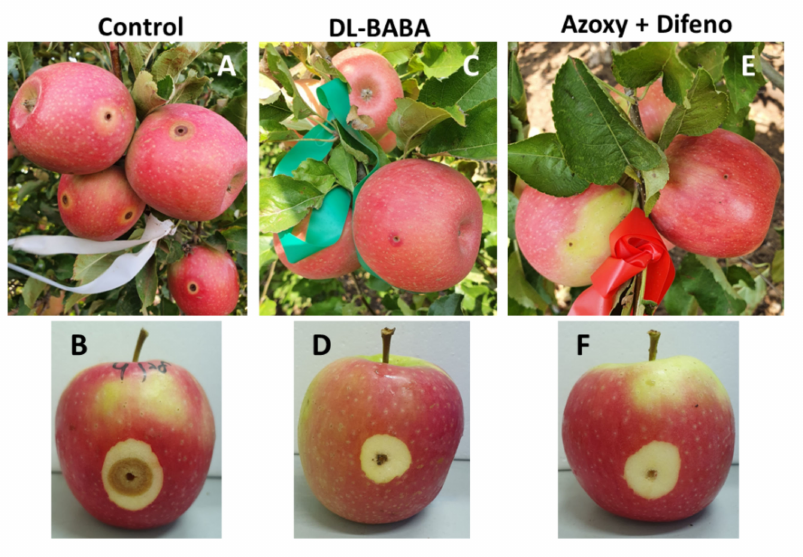
Figure 7. Fruit rot development following artificial inoculation in the orchard: ( A , B ). Rot developed on untreated fruits; ( C , D ) Rot developed on fruits treated with BABA; ( E , F ) Rot developed on fruit treated with the pre-mixture azoxystrobin plus difenoconazole (Azoxy +